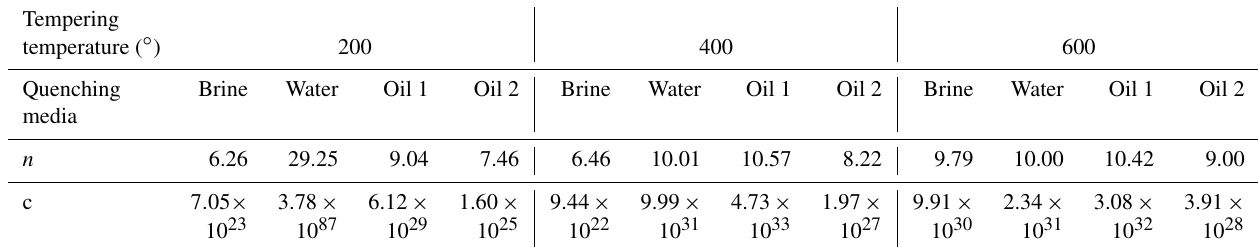
Figure 5. Standard deviation of fatigue life. Table 3. Material constants of S–N